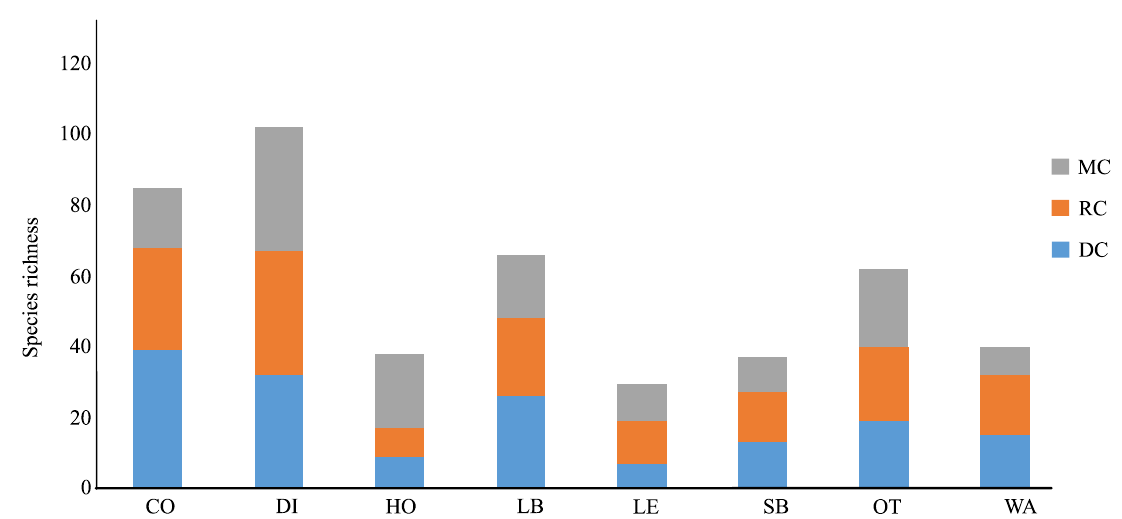
Figure 2. The total number of pollinator species that belong to each functional group (in alphabetical order) in each study community: coastal dune community (DC), rocky coastal community (RC) and mountain community (MC). The functional groups are Coleopterans (CO), Dipterans (DI), Hoverflies (HO), Large bees (LB), Lepidoptera (LE), Small bees (SB), Others (OT), and Wasps (WA). Data from 2009 and 2010 were pooled.